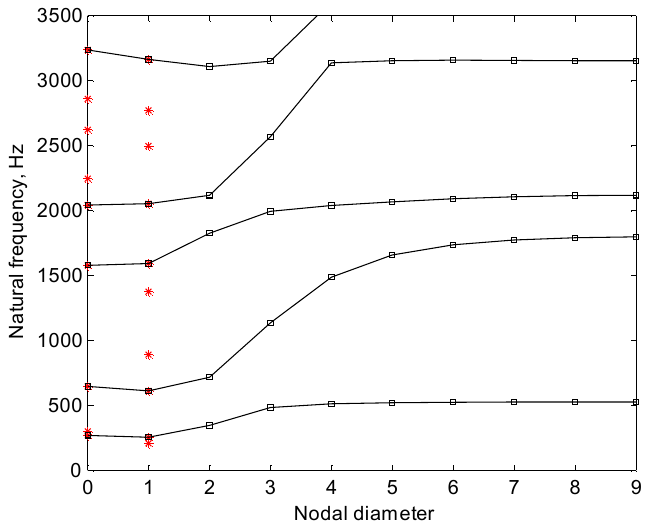
Figure 2. Natural frequencies versus nodal diameters of the tuned blade–disc–shaft assembly in a static condition.